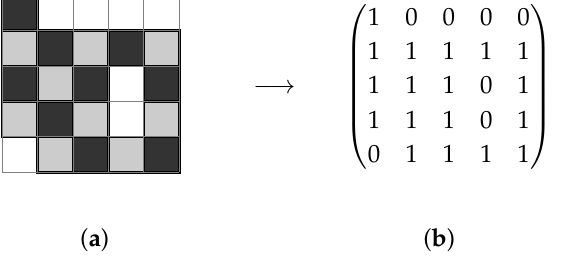
Figure 10. Constructing the binary matrix for a checkerboard coloured region R : ( a ) the target region R ; ( b ) binary matrix B